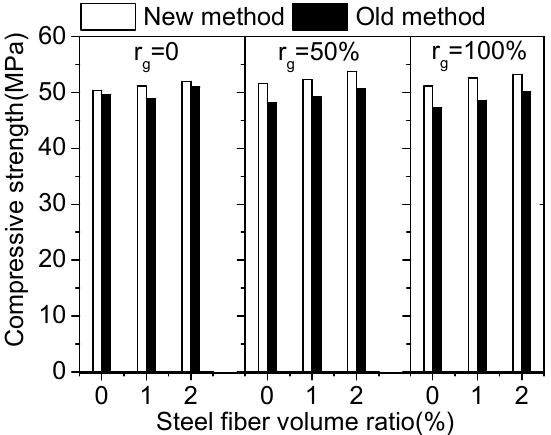
Figure 6. Comparison of compressive strength by using different sand ratio method.